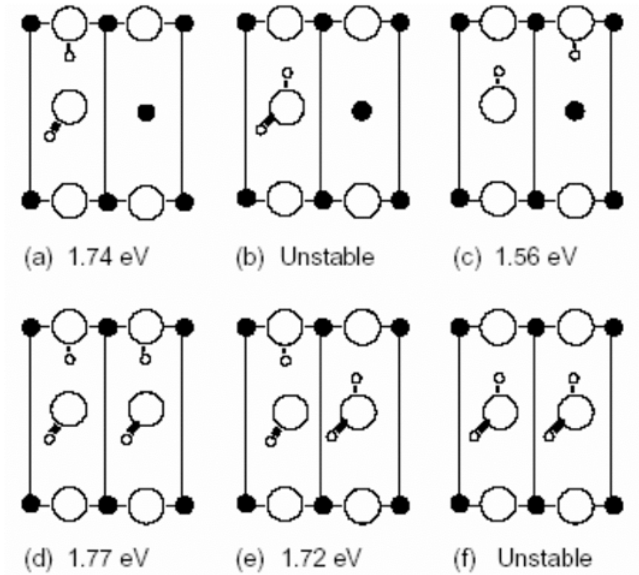
Figure 11 . Schematic representation of the adsorption geometries of water on SnO calculations. Oxygen, tin and hydrogen are represented by large, small filled and small open circles respectively. Half coverage (top) and monolayer coverage (bottom) are considered. Adsorption energies are also given. (reproduced with permission from ref.